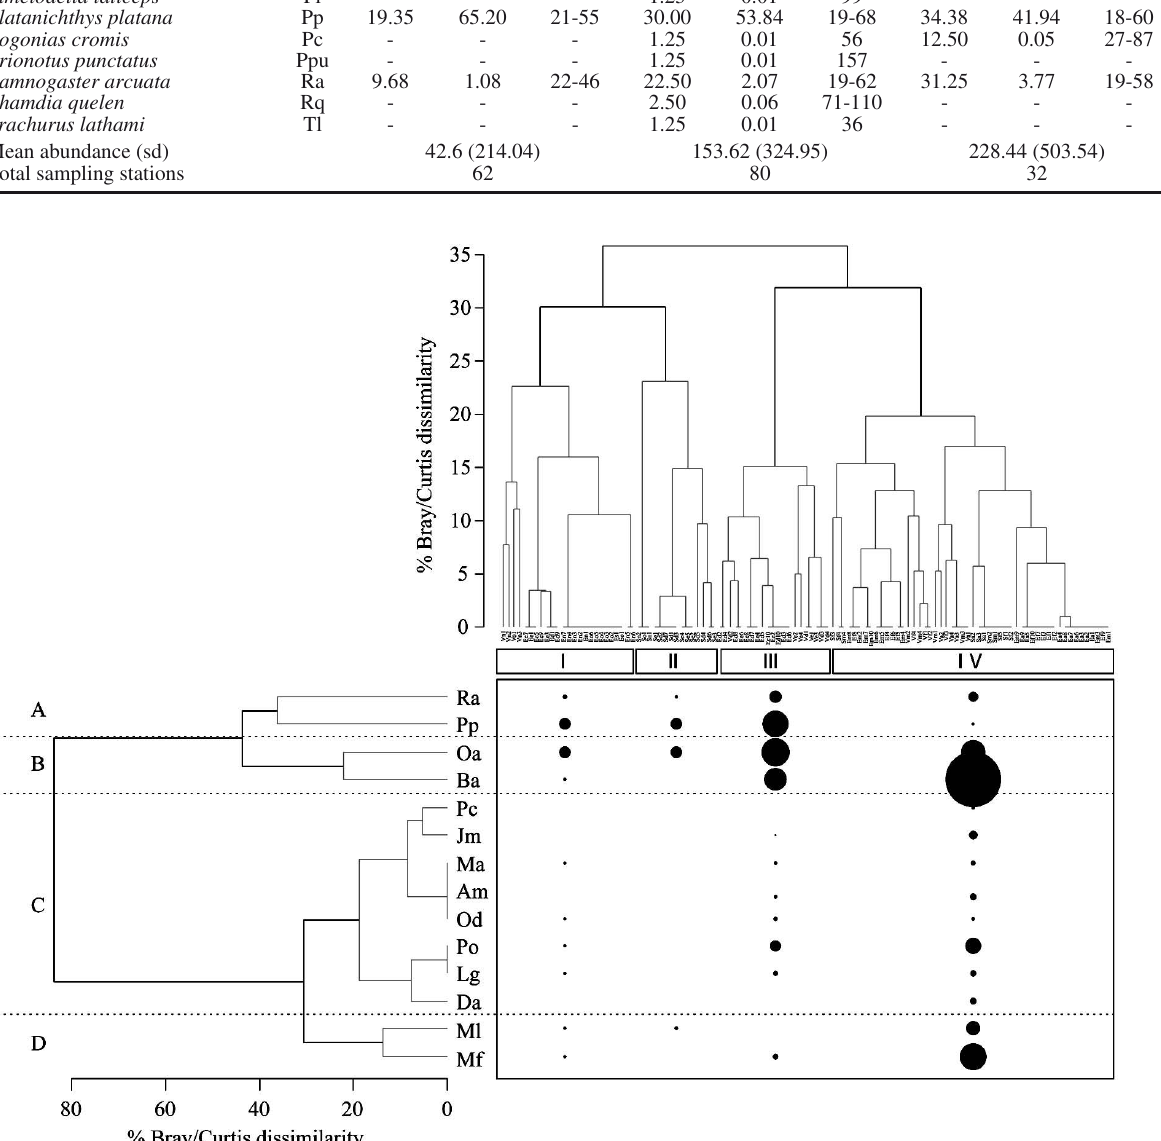
Fig. 4. – Dendrogram derived from subjecting fish species abundances to cluster and SIMPROF using the Bray/Curtis dissimilarity measure and group average sorting. Groups of samples marked by light grey lines are those which do not contain significant internal structure and thus represent fish groups. Group I, spring months in the estuary and the Vivoratá stream; Group II, spring–early summer months in the surf zone; Group III, early summer months in the estuary and the Vivoratá stream; Group IV, late summer–early autumn months in the three zones. Symbol size is proportional to the abundance of each taxon in each group of stations. See Table 2 for species